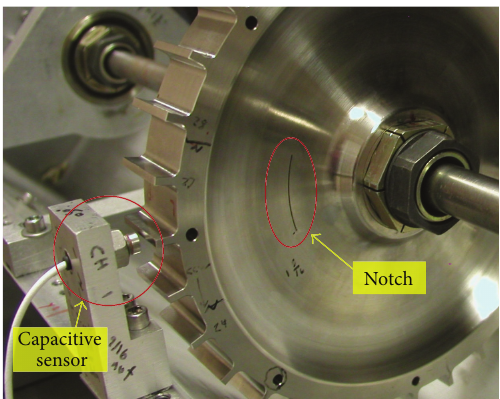
Figure 7: Capacitive blade tip clearance sensor and subscale turbine engine disk with